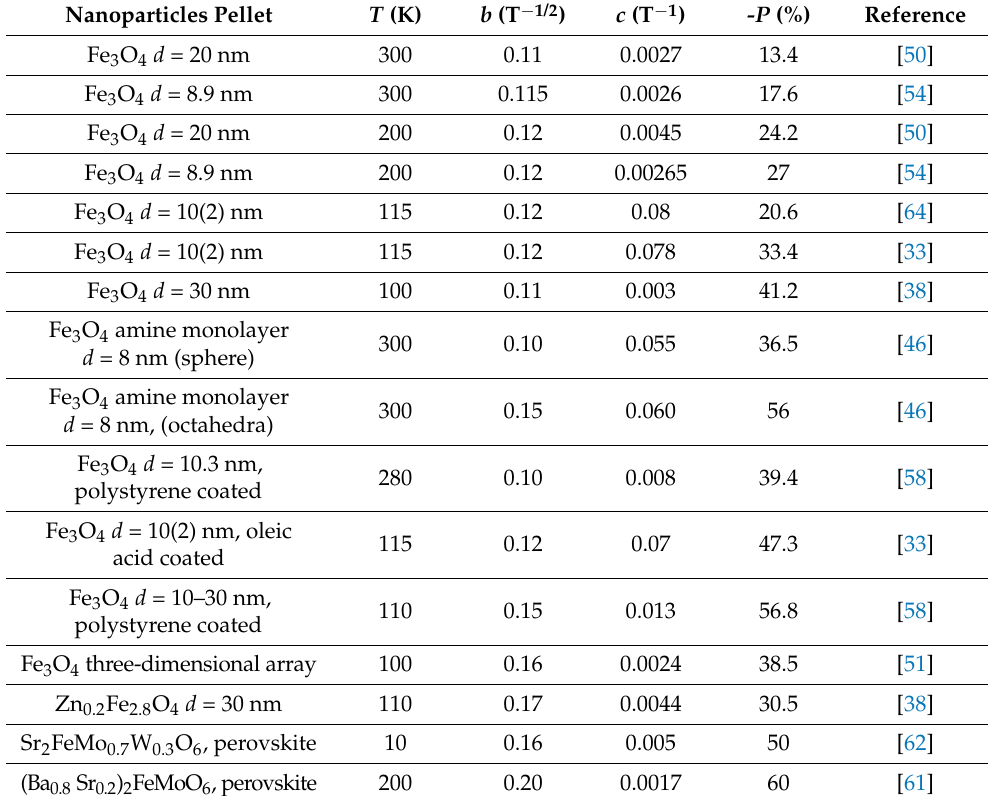
Table 2. Data obtained from magnetoresistance measurements. Nanoparticles